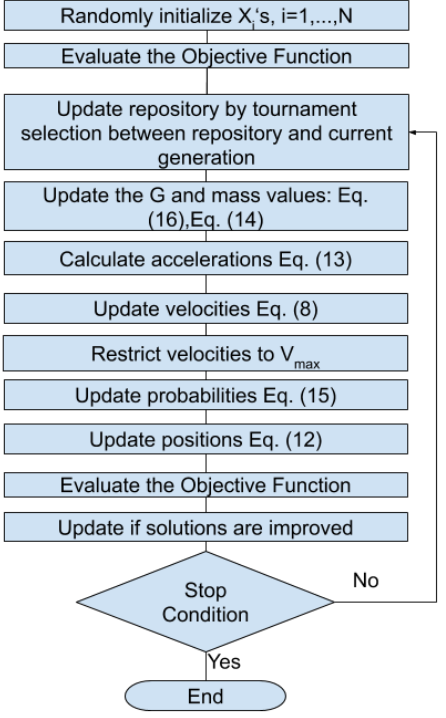
Figure 1. Flowchart of the proposed XOR binary gravitational search algorithm